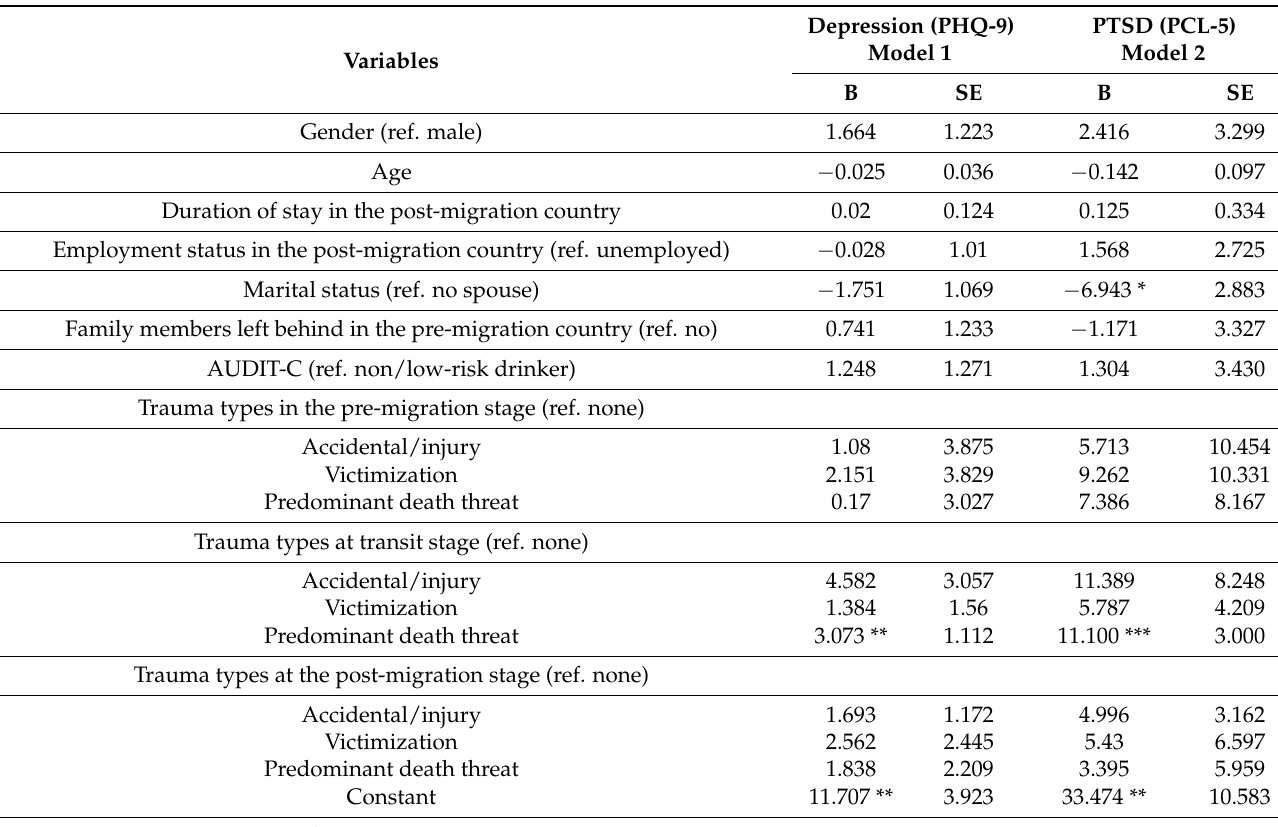
Table 2. Seemingly unrelated regression model of depression and PTSD among North Korean refugees ( n =